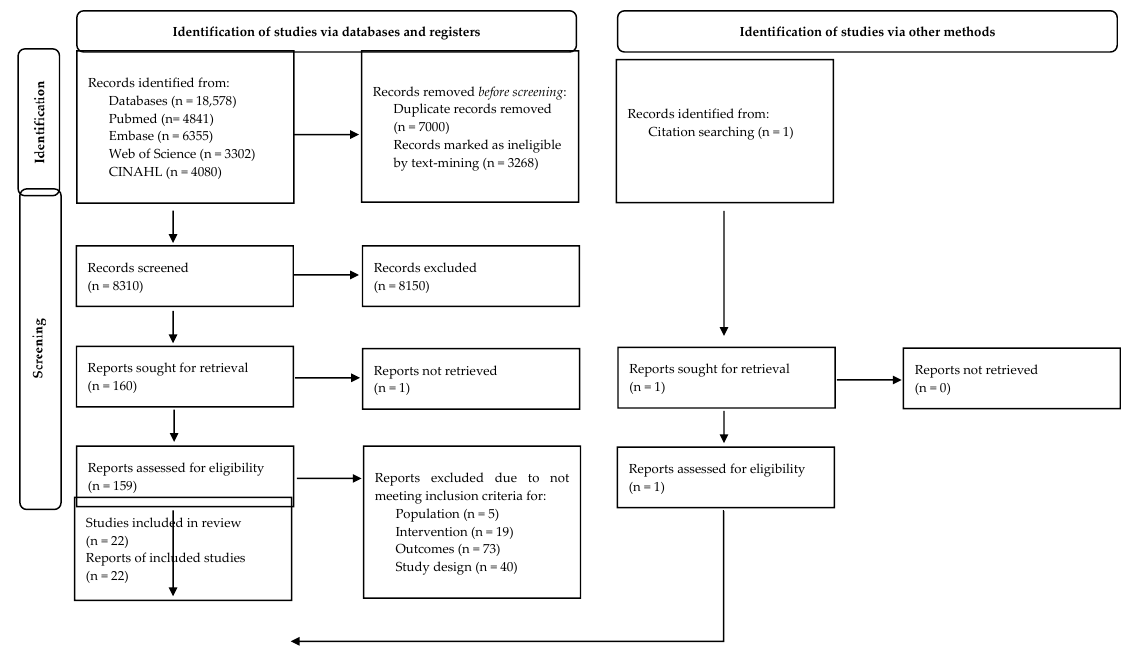
Figure 1. Preferred Reporting Items for Systematic Reviews and Meta-Analysis flowchart of the search results and the included studies.